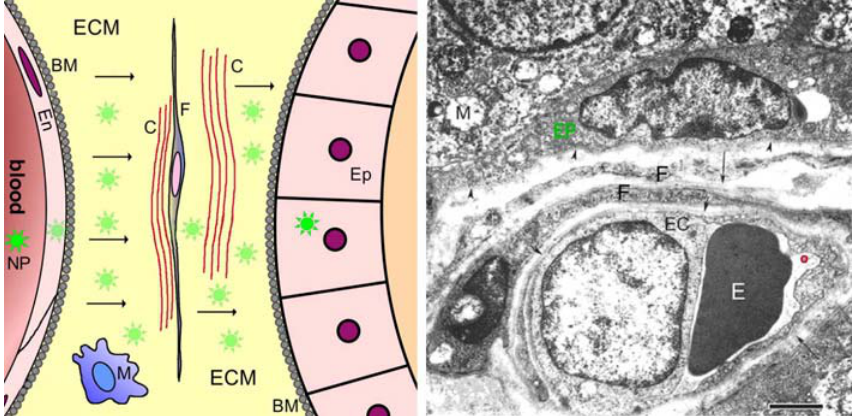
Figure 2. Barriers between blood and glandular epithelium, sketch at left, electron micrograph at right. The image at left is a sketch diagram of structural barriers between blood and parenchymal epithelial cells (Ep) of an organ (e.g., gland). This Figure shows details omitted in stage 3 of Figure 1. After crossing the blood-tissue barrier ( stage 2 ) consisting of the endothelial cell sheet (En), the subendothelial basement membrane (BM), pericytes and (possibly) smooth muscle cells, the nanoparticles (NP, green stars) must cross (arrows) the perivascular compartment, which contains the extracellular matrix (ECM) consisting of glycosaminoglycans, proteoglycans and proteins, the collagen fibrils and fibril bundles (C), the sheetlike processes of fibroblasts (F), occasional nerve fibres and immune cells such as macrophages (M), and the subepithelial basement membrane (BM). The image at right is an electron micrograph showing these barriers in a tissue specimen. The image shows a capillary in the peritumoral region of a prostate carcinoma of human (from Wieser et al. [51]). In this peritumoral region, the blood-tissue barrier is essentially intact (truly normal tissue of human prostate gland is difficult to obtain in a good state of ultrastructural preservation!). The arrowheads and arrows all point to basement membranes. Nanoparticles in the blood volume (a rather large one is encircled red) can interact with cells in the blood (such as the erythrocyte, E) or with the apical surface of the endothelial cell (EC). Lying beneath the endothelial cell layer are the subendothelial basement membrane, then the extracellular matrix containing collagen fibres and glycosaminoglycans. Within the extracellular matrix are embedded fibroblasts (F), two layers in this case, then resting upon its own basement membrane the prostate glandular epithelium (EP, green text), which is the target. The washed-out state of the mitochondria (M) in the epithelial cells is due to the period elapsing between operative removal of the tissue and fixation in aldehydes. Calibration bar: 2